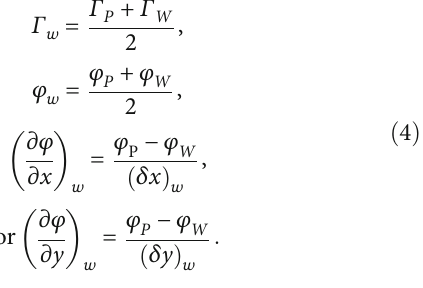
Figure 2 is a schematic diagram of volume unit division